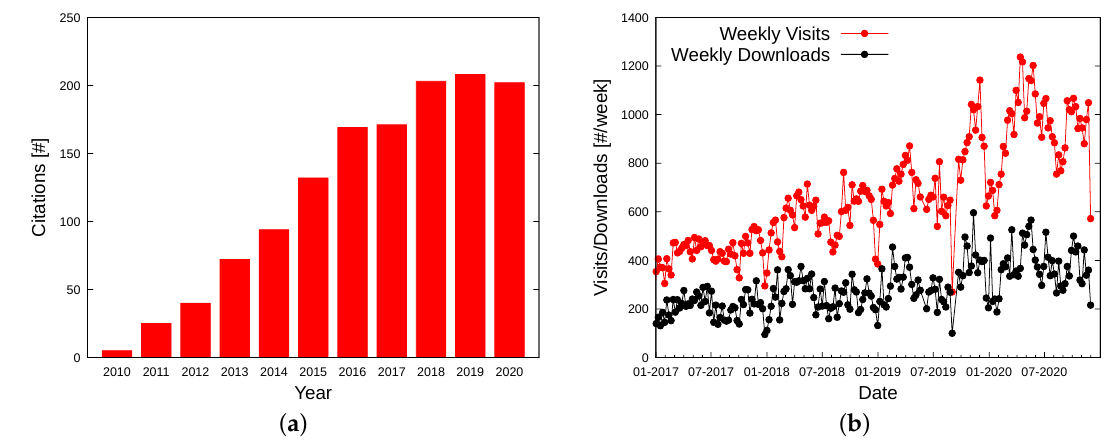
Figure 3. Statistics about LXCat: ( a ) Number of citations of the LXCat website per year in scientific publications according to Google Scholar research engine up to 3 December 2020. ( b ) Number of visits and downloads per week over the last